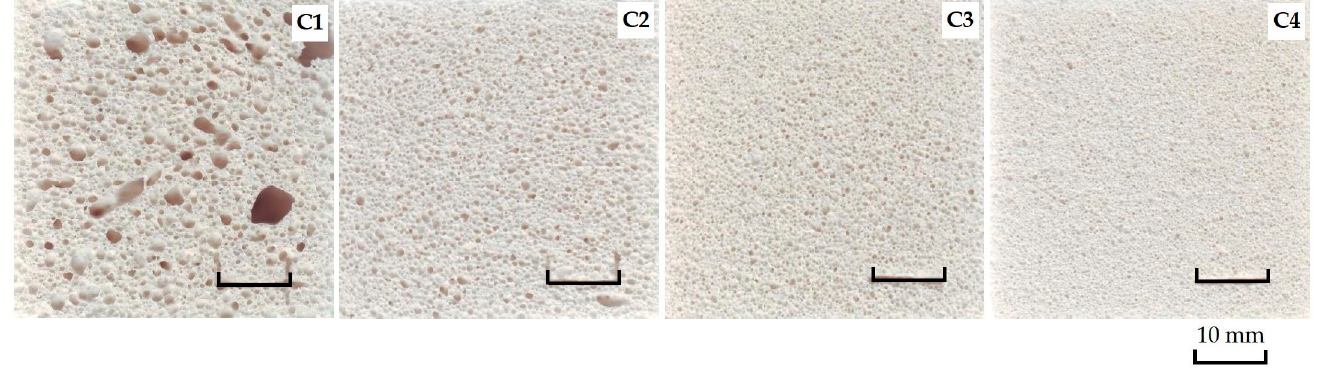
Figure 3. Scan of the surface of porous glass-ceramic samples.